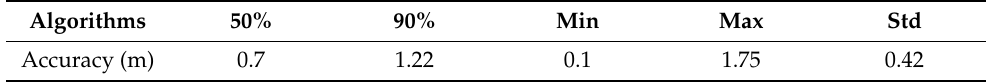
Figure 11. CDF for the position errors using the auto-fingerprinting technique. Table 4. Summary of localization results.